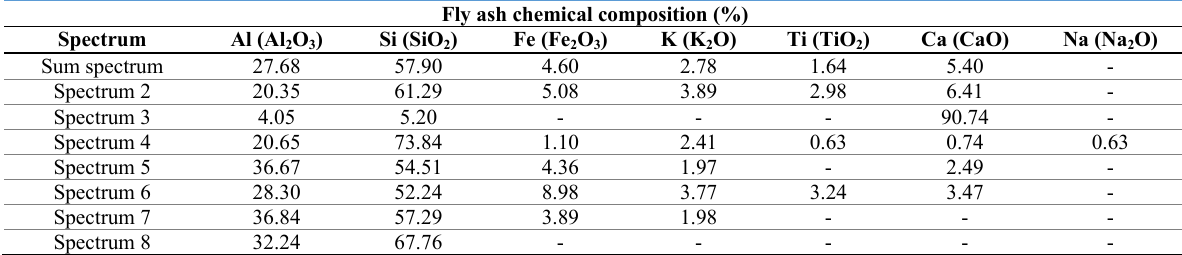
Coal bottom ash composition (%)